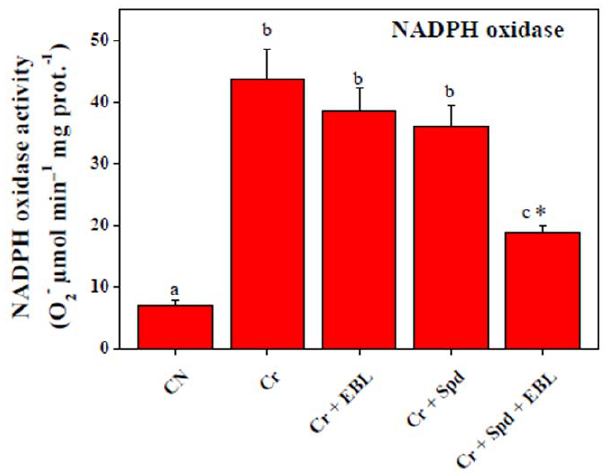
Figure 6. NADPH oxidase activity (O 2 2 2 m mol min 2 1 mg prot. 2 1 ) in 7-d-old radish seedlings under Cr-stress without or with EBL and /or Spd. Data are presented as mean 6 SE. Different superscripted letters (a, b, c) indicate significant difference from each other in all combinations (Tukey’s test, p , 0.05). Asterisk ‘‘*’’indicates significant difference for EBL + Spd vs. EBL under Cr-stress (Tukey’s test, p , 0.05).